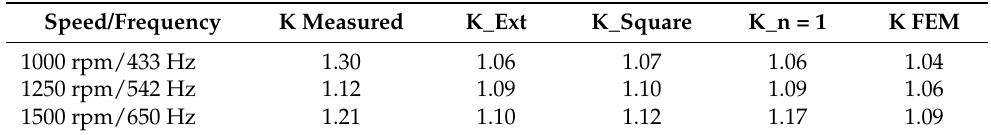
Table 3. Comparison of the coefficient K.